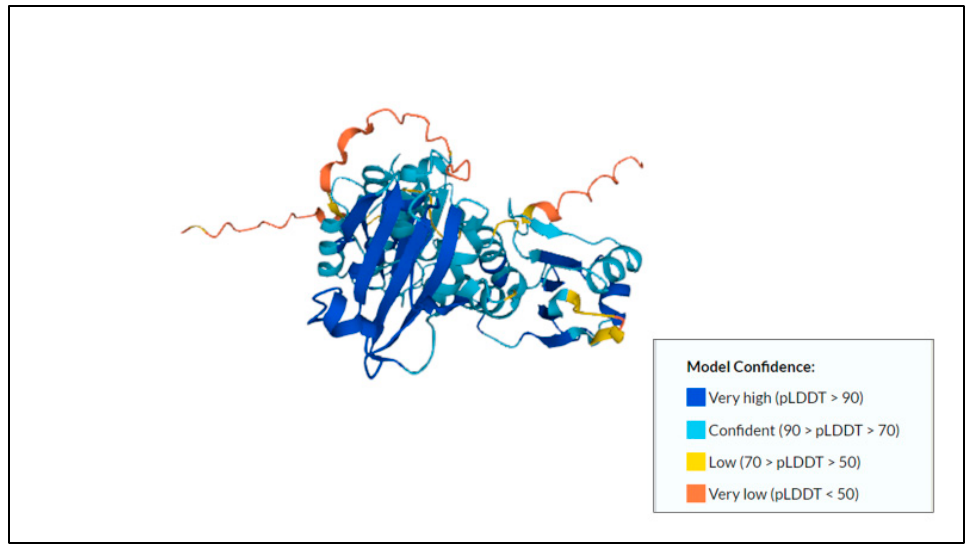
Figure 4. Predicted protein structure of thioredoxin (putative) [41,65,68] https://www.uniprot.org/uniprotkb/S0AYD1/entry, accessed on 25 October 2022.